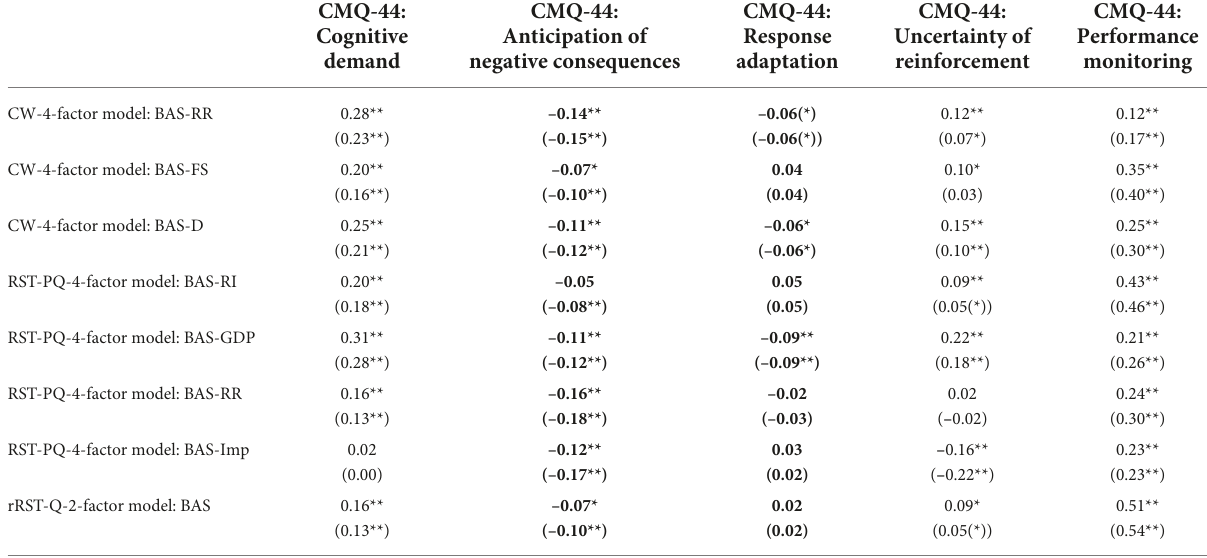
TABLE 7 Spearman rank correlations of the factor score-based trait-BAS-related scales ( N =